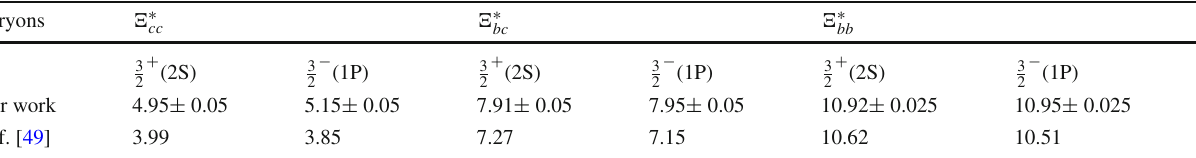
, and (cid:2) ∗ (in units of GeV) bc bb